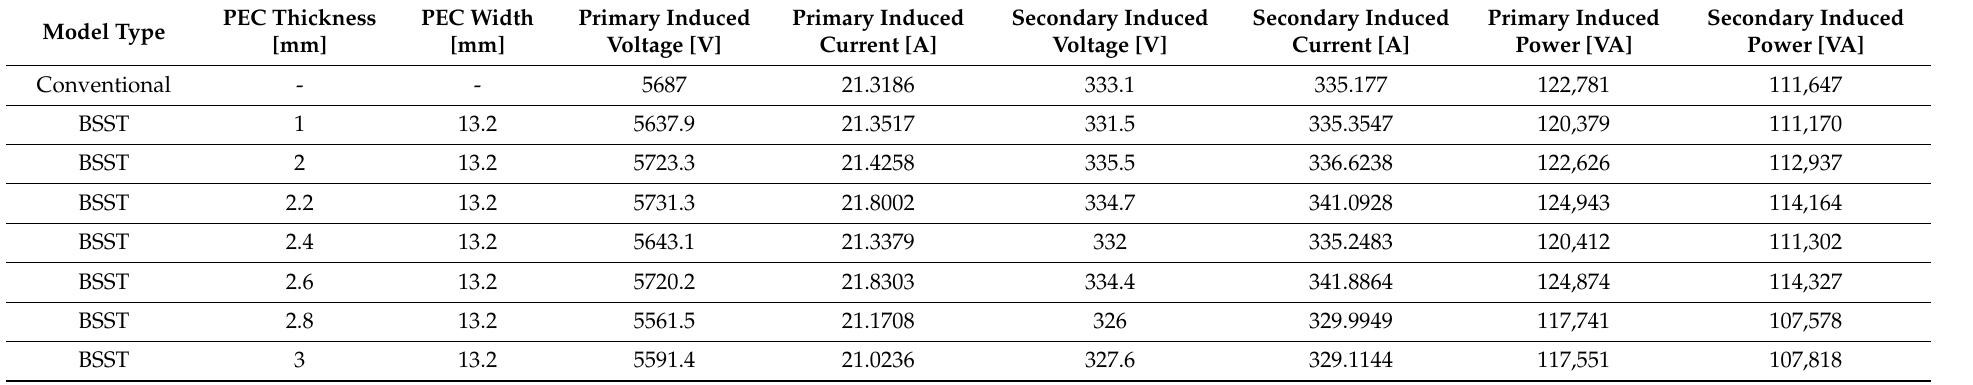
Table 3. Simulation results for different PEC dimensions and conventional transformer